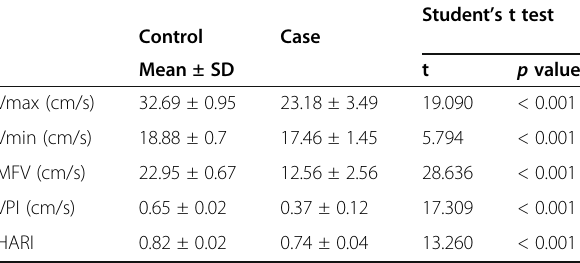
Student ’ s t test